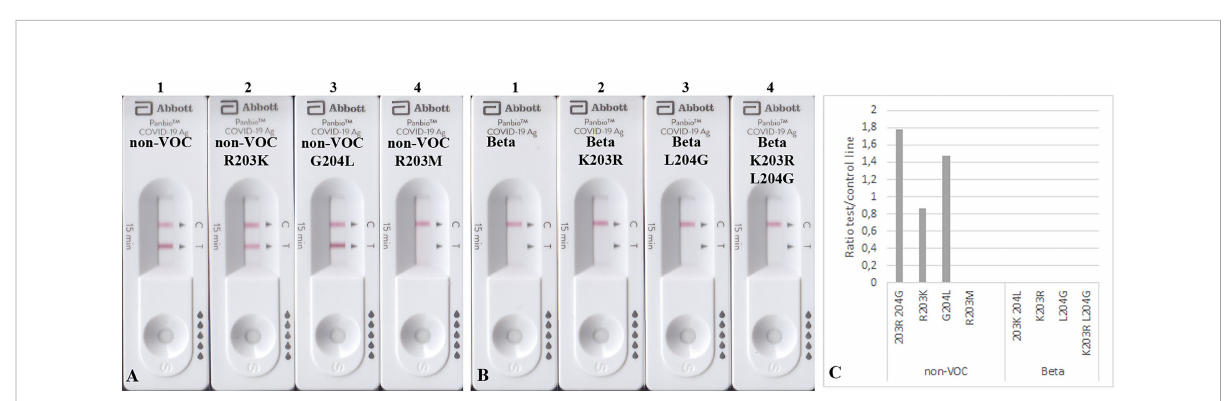
FIGURE 5 Detection of 100 ng mutated N proteins by RATs from Abbott. Numbers label speci fi c RATs in (A) and (B) for easier orientation Amino acid change at position 203 (A2) decreases the test line intensity, whereas the change at position 204 (A3) of the non-VOC N protein does not have an effect. R203M mutation (A4) also impairs the detection by these RATs. (B) All N proteins on the Beta background were not detected. (C) Densitometric analysis of RATs shown in (A, B) .